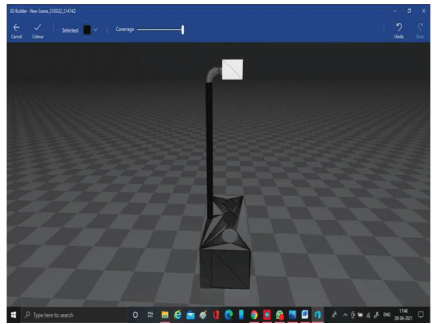
Figure 13: Front view of the body.